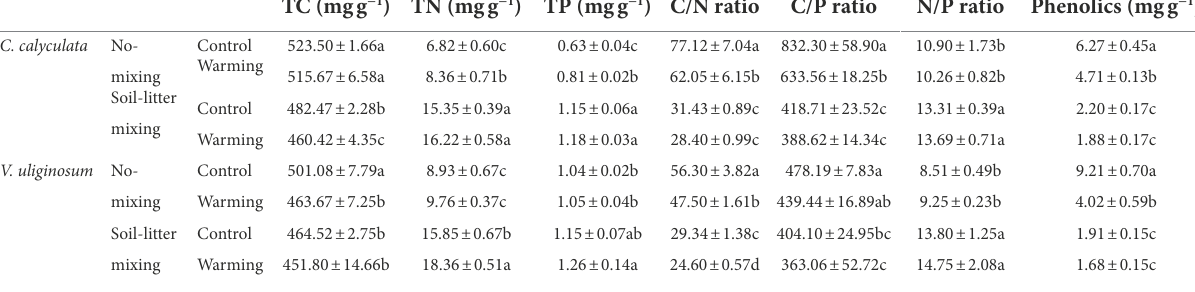
TABLE 3 The effects of warming and the litter positions on the TC, TN, TP, and phenolics contents of the C. calyculata and V. uliginosum